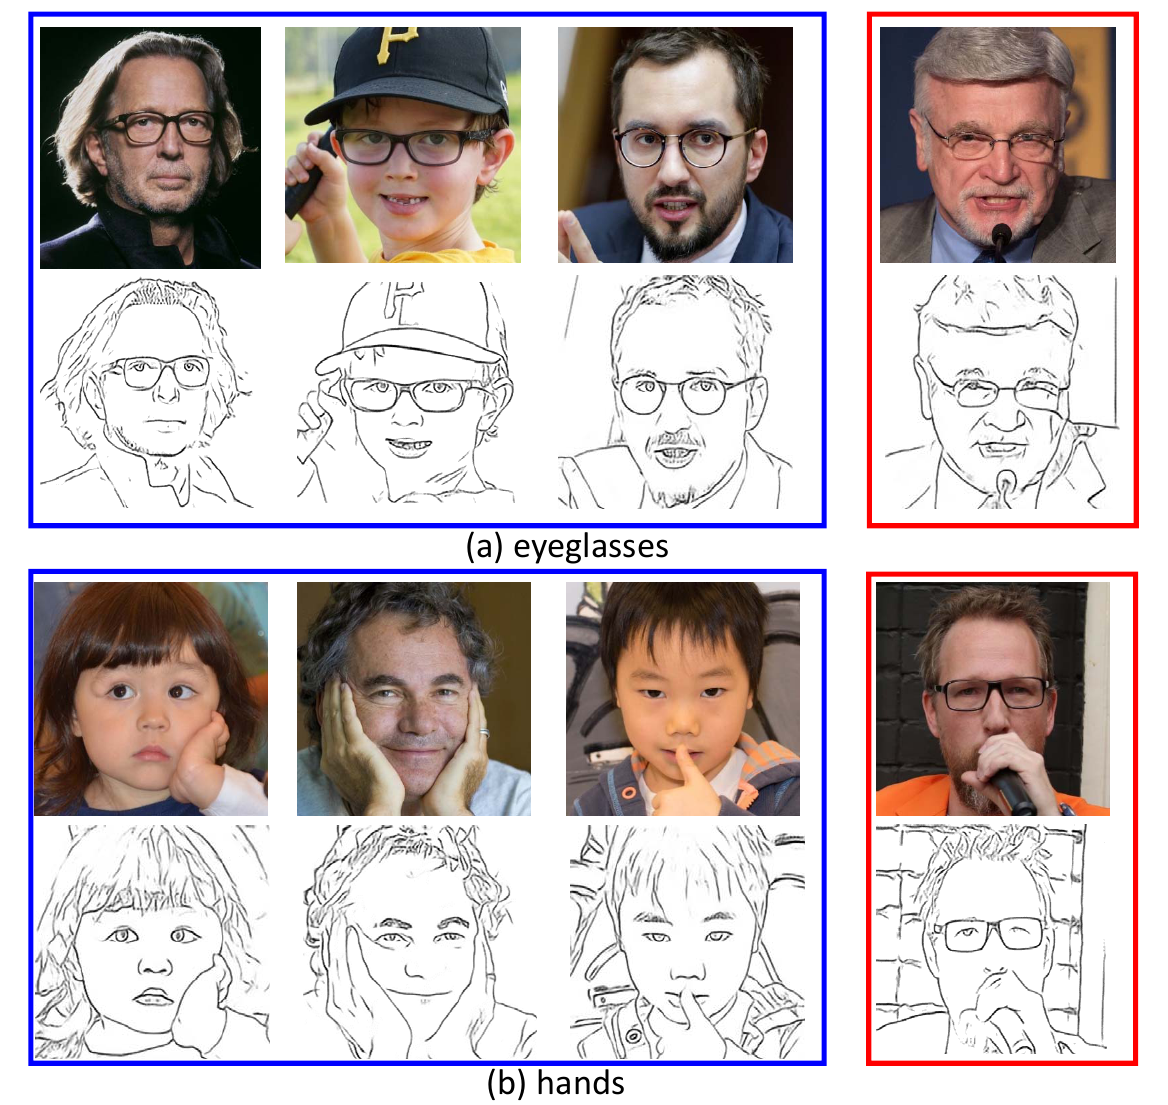
Figure 6. Results from portraits with obstacles. The images in the blue box show convincing results, while the images in the red box show somewhat unsatisfactory